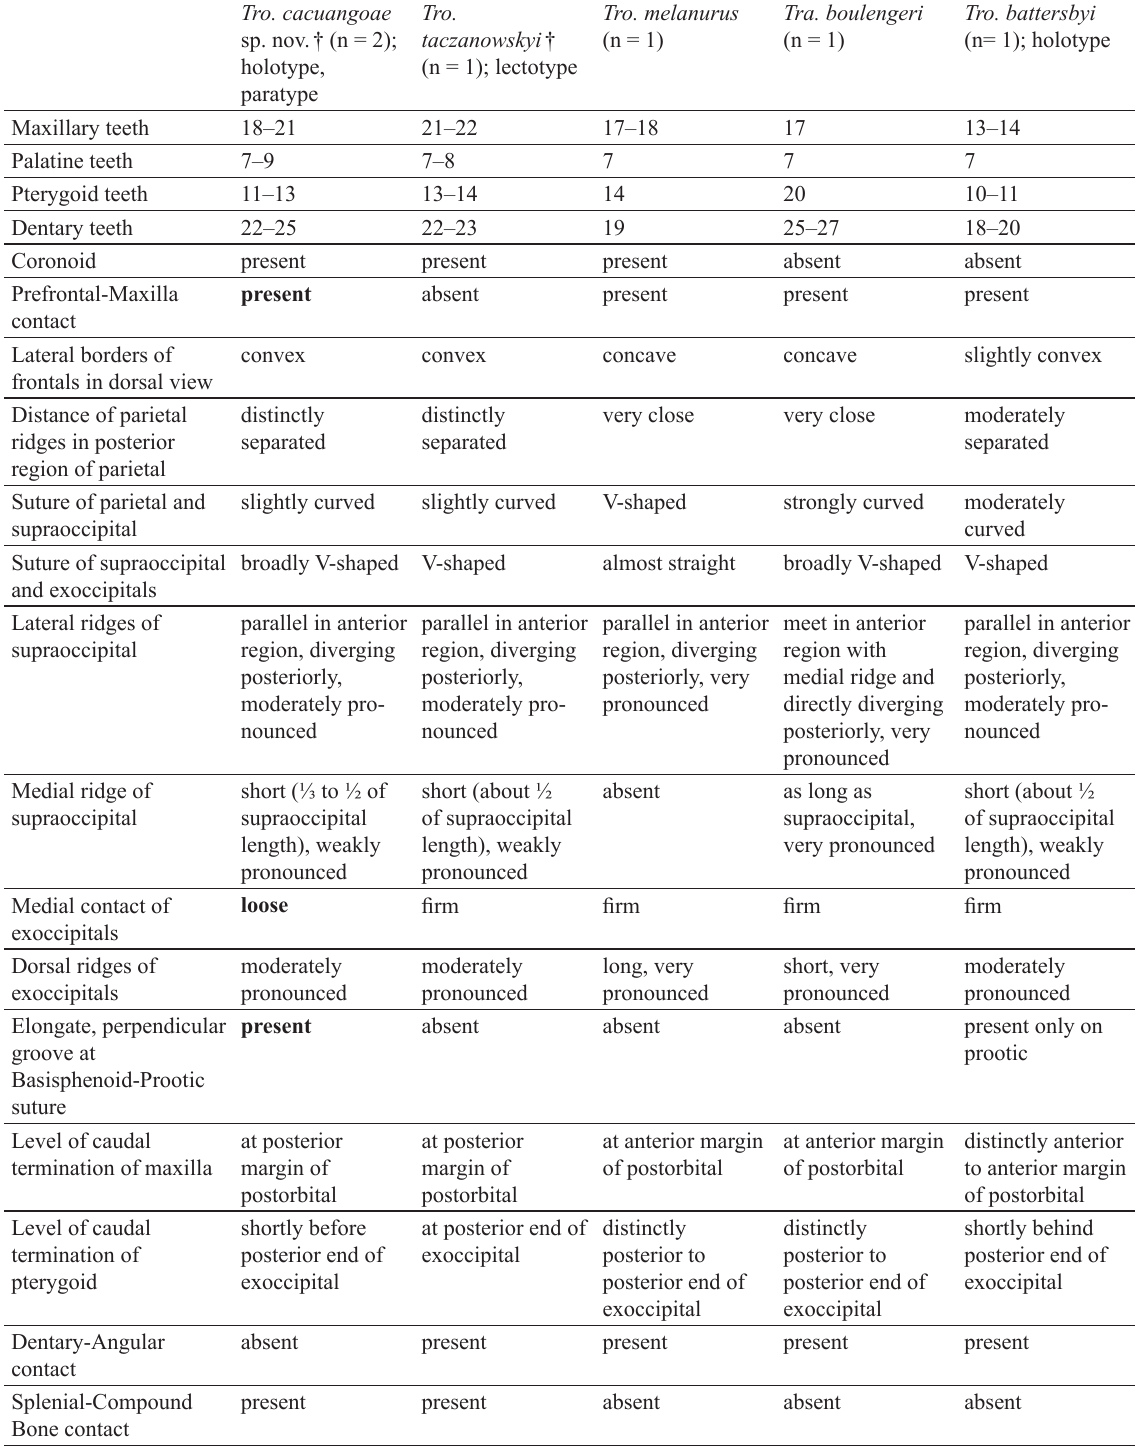
Table 1. Osteological comparisons among selected species of Tropidophis Bibron, 1840 and Trachyboa boulengeri Peracca, 1910. Diagnostic characters of Tropidophis cacuangoae sp. nov. are highlighted in bold. Species with confirmed records from the Andes mountain range are indicated with a dagger